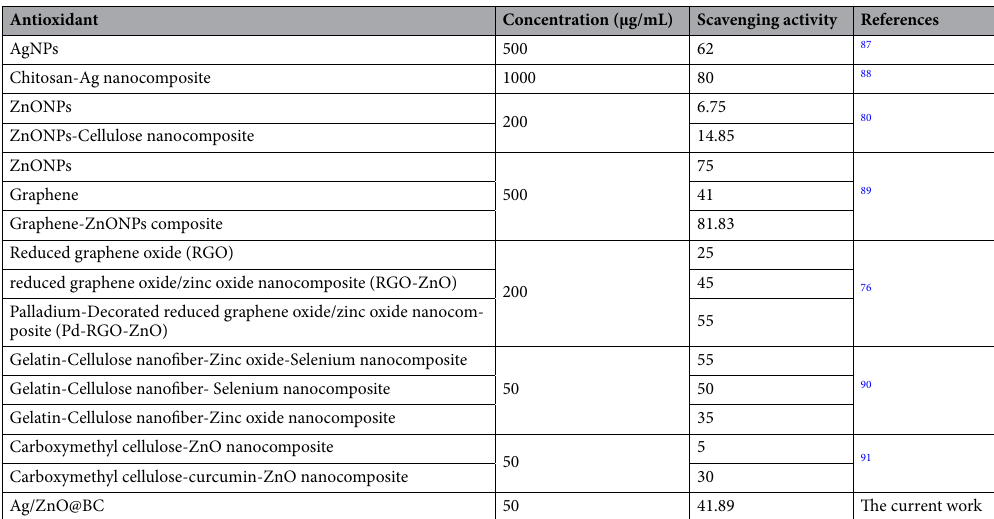
Table 2. Comparison between the antioxidant efficiency of Ag/ZnO@BC prepared in the current study and other nanomaterials including various nanocomposites prepared in different studies.